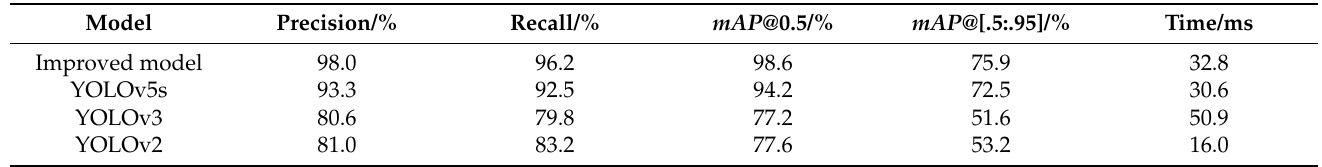
Table 4. Comparison of improved model